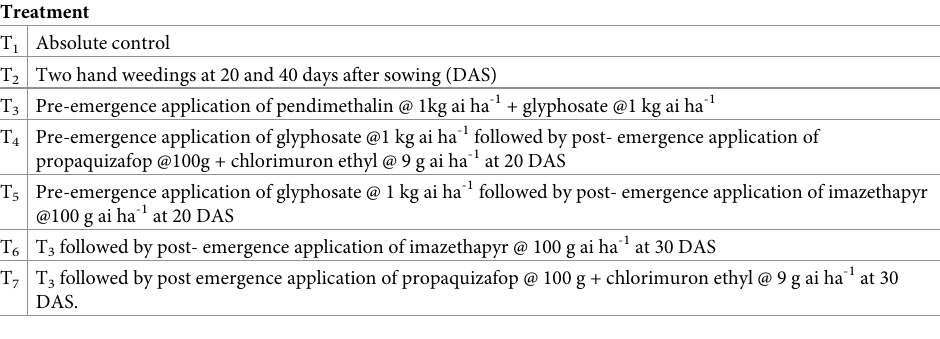
Table 1. Details description of treatments used in the experiment during